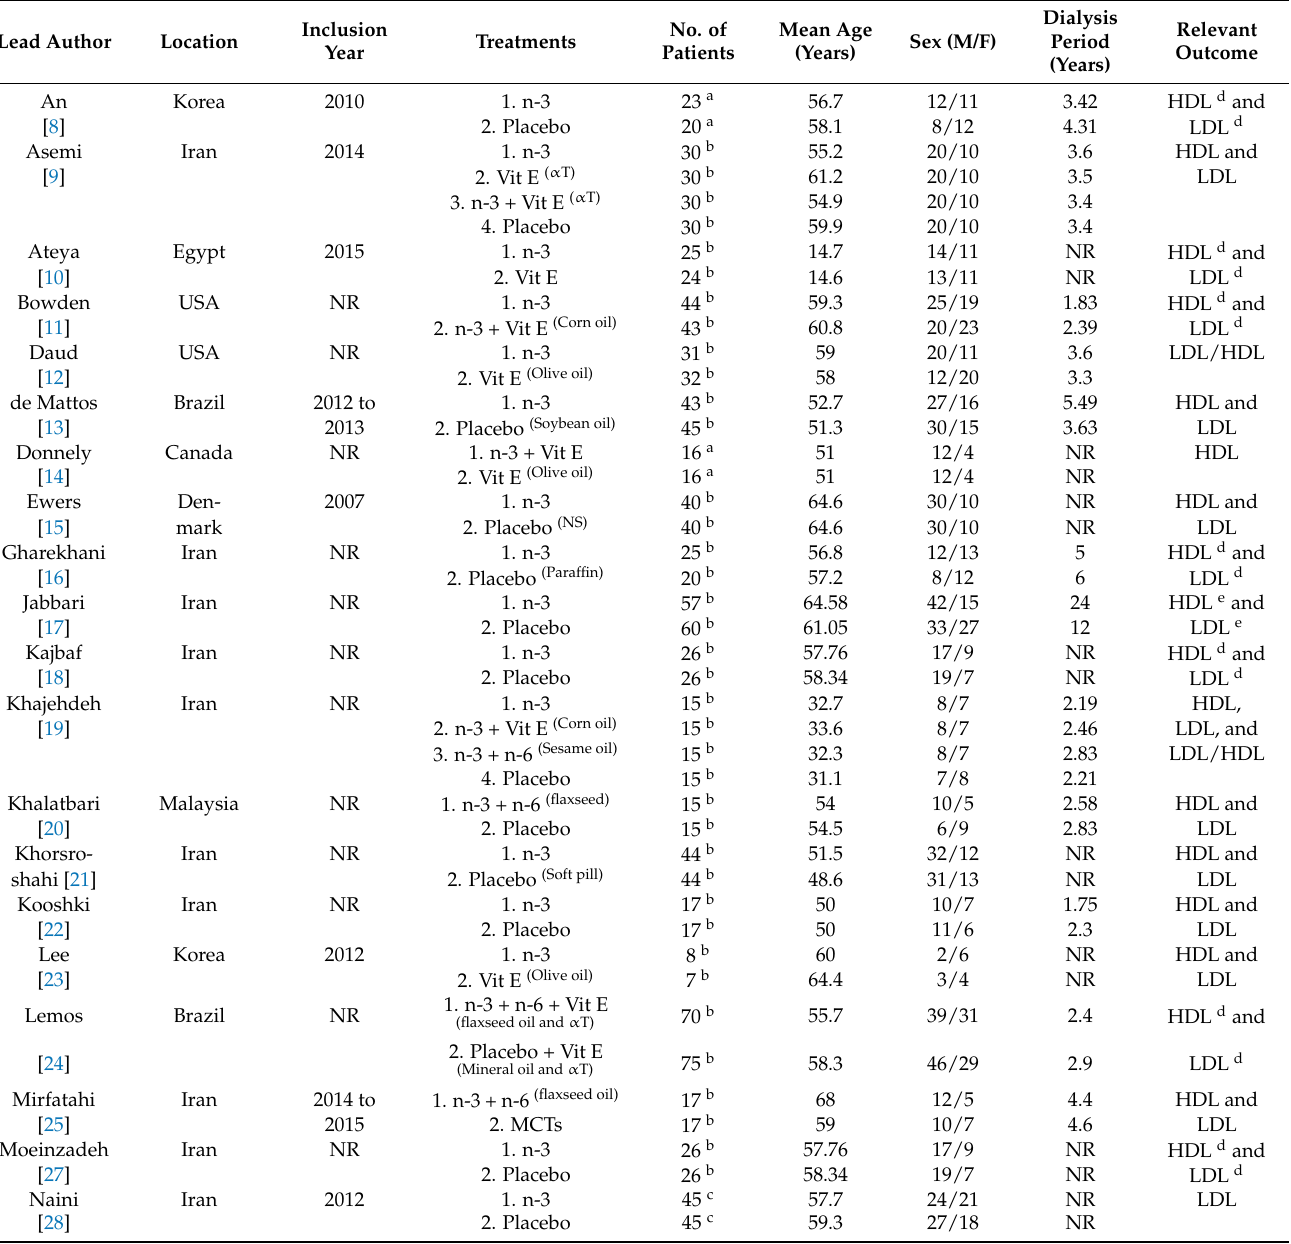
Table 1. Characteristics of the included randomized controlled